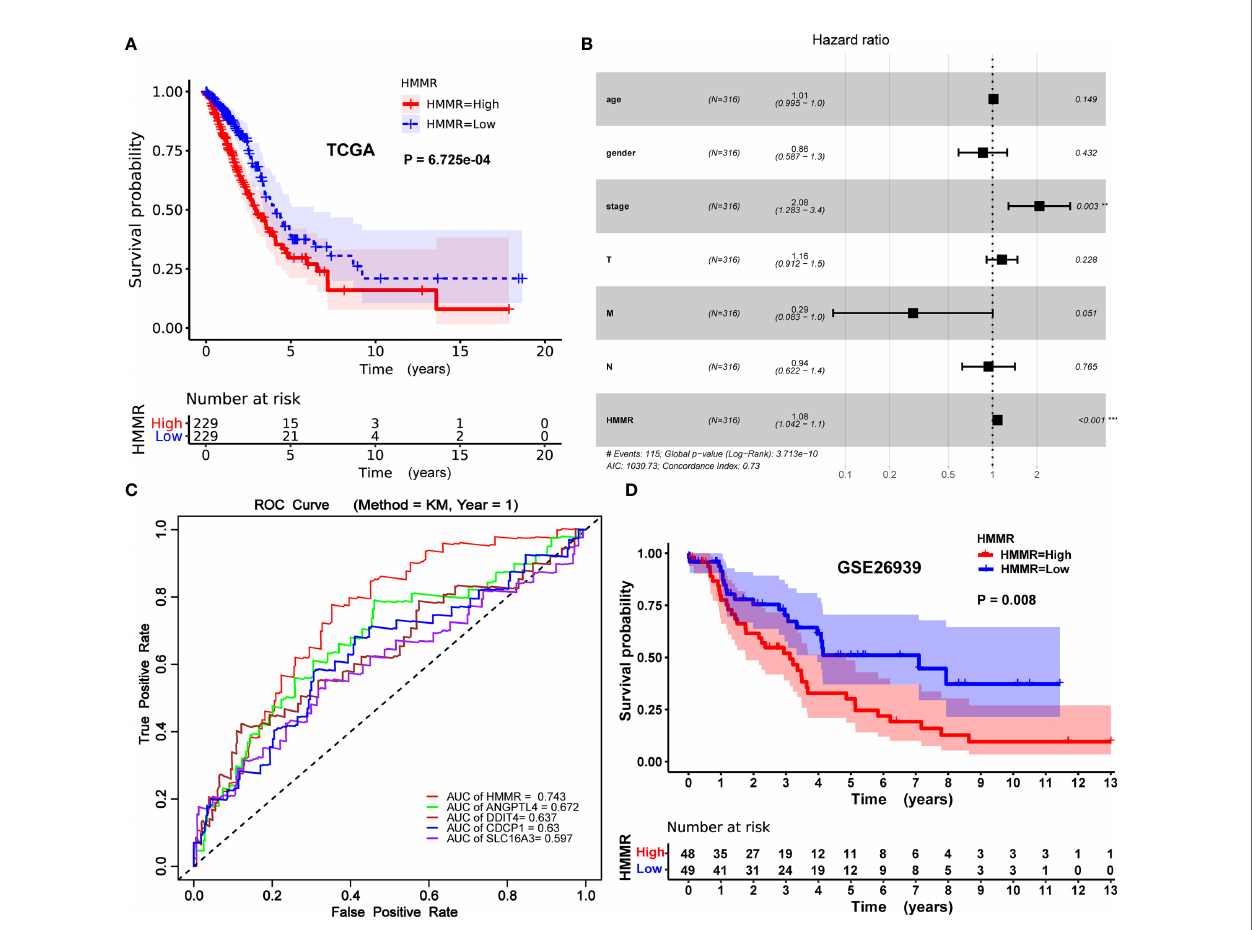
FIGURE 4 | Prognostic role of HMMR in LUAD patients. (A) Kaplan – Meier curve of the association between HMMR mRNA expression and the prognosis of LUAD patients. (B) Forest plot of the multivariate Cox proportional hazard regression model indicated that HMMR was an independent predictor of poor survival rate (HR: 1.080, 95% CI: 1.042 – 1.120, p = 0.000). (C) ROC curves of evaluating the accuracy of each prognostic gene. (D) Kaplan – Meier curve of the association between HMMR mRNA expression and the prognosis of LUAD patients in GSE26939. Hazard ratio (HR), con fi dence interval (CI), receiver operating characteristic (ROC), area under the curve (AUC). (* p < 0.05, ** p < 0.01, *** p < 0.001).